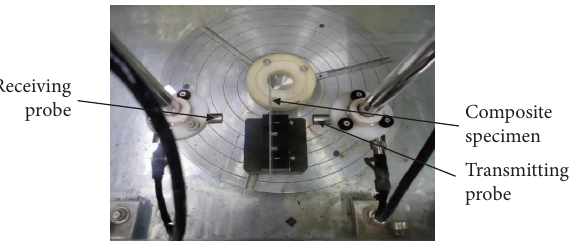
Figure 12: Trough transmission setup with the